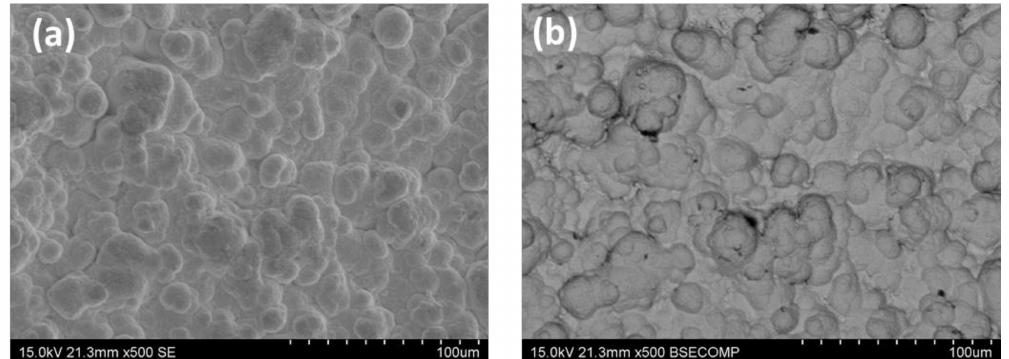
Figure 3. SEM images of the external surface after the palladium incorporation by electroless pore-plating (ELP-PP): ( a ) SE and ( b ) BSE.